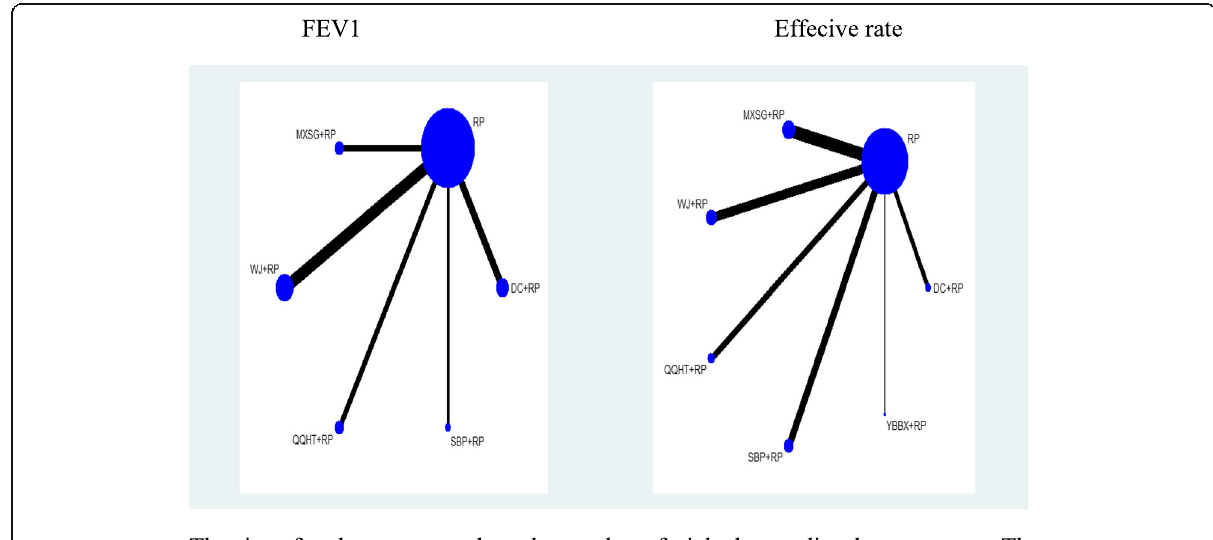
Fig. 3 Network diagram for FEV1 and effective rate